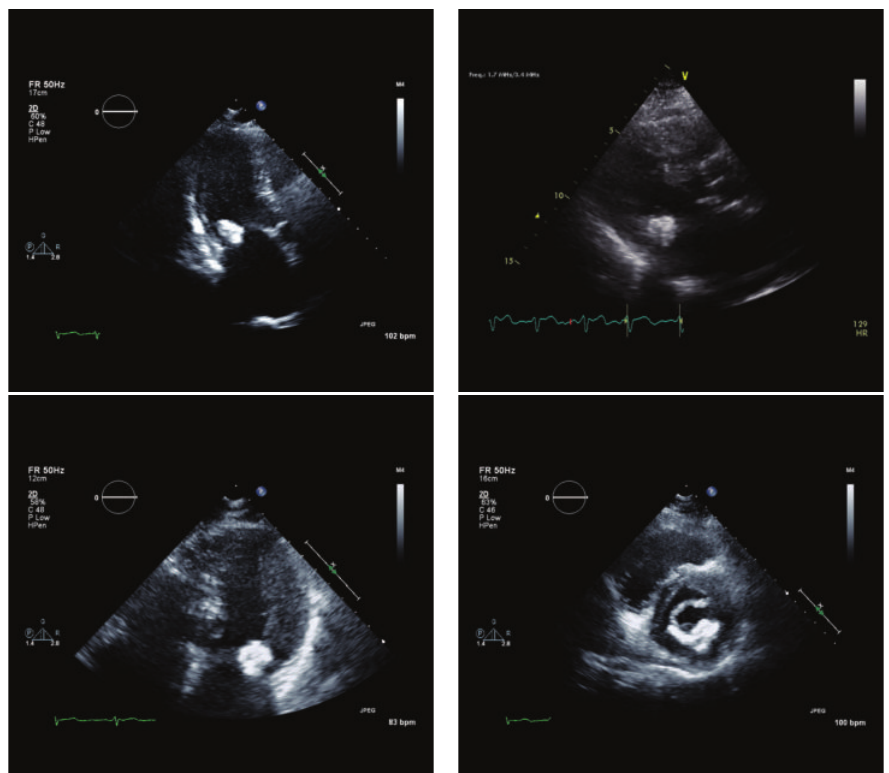
Figure 1: Transthoracic echocardiogram views. Four standard views that show a round echodense mass measuring 20 × 23 mm along the mitral annulus and attached to the posterior mitral